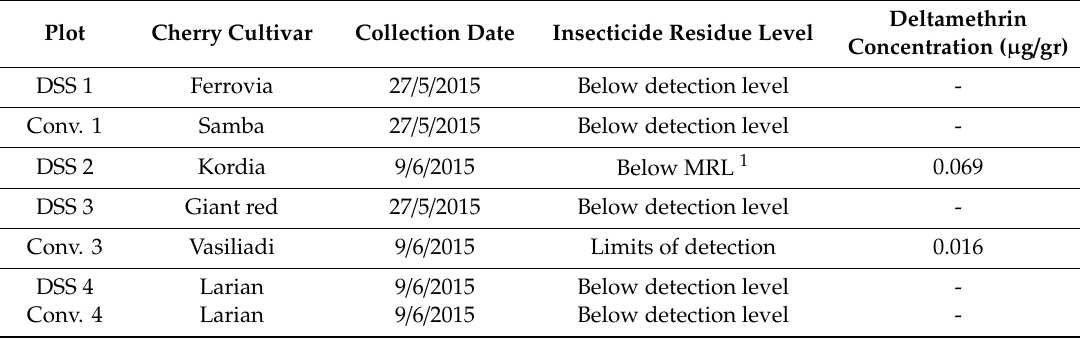
Table 5. Insecticide deltamethrin residue levels of cherry cultivars collected in di ff erent plots during cherry